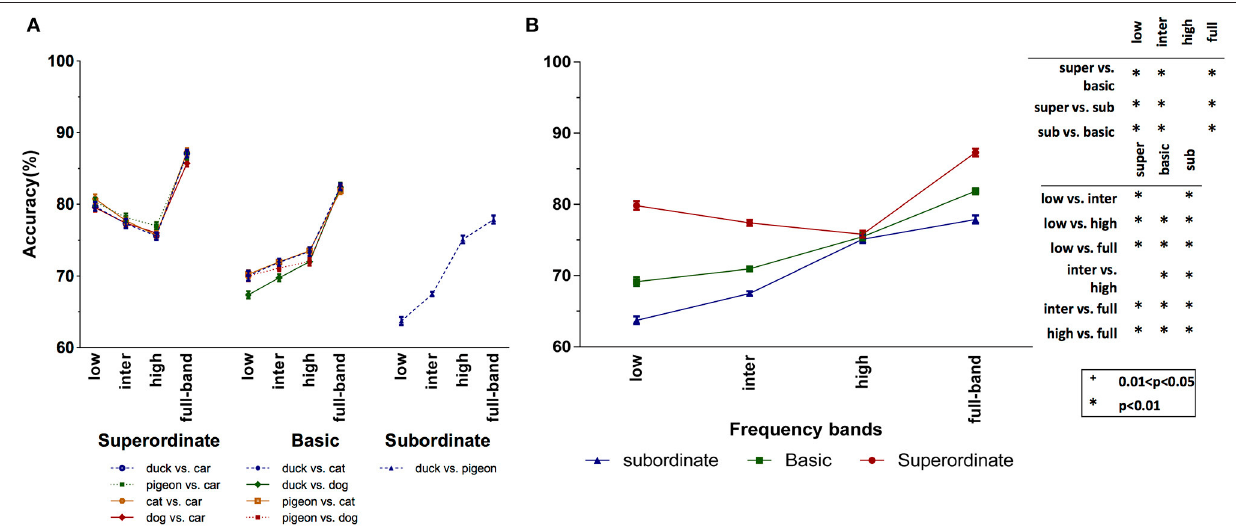
FIGURE 7 | Mean accuracies of Model II (averaged over 10 independent run) for different categorization levels and spatial frequency bands. (A) Model’s accuracy for the different tasks of each categorization level. (B) Average accuracies over the different tasks of the superordinate (duck vs. car, pigeon vs. car, cat vs. car, and dog vs. car), basic (duck vs. cat, duck vs. dog, pigeon vs. cat, and pigeon vs. dog) and subordinate (duck vs. pigeon) levels. The p -value matrix presents the significant and strongly significant values using + and * signs, respectively. Error bars represent standard error of the mean (SEM). The between (within) group df is 11